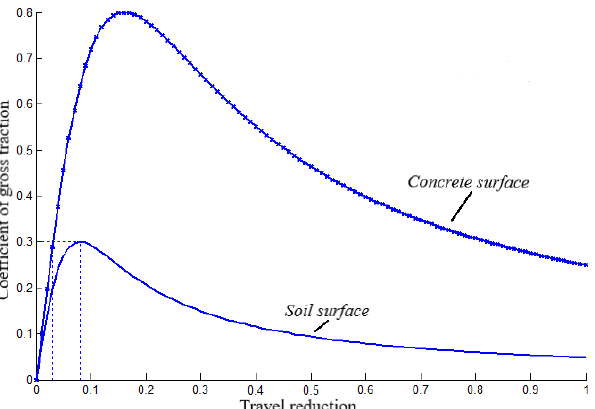
Figure 5. Relationship between travel reduction and coefficient of gross traction of road surface.